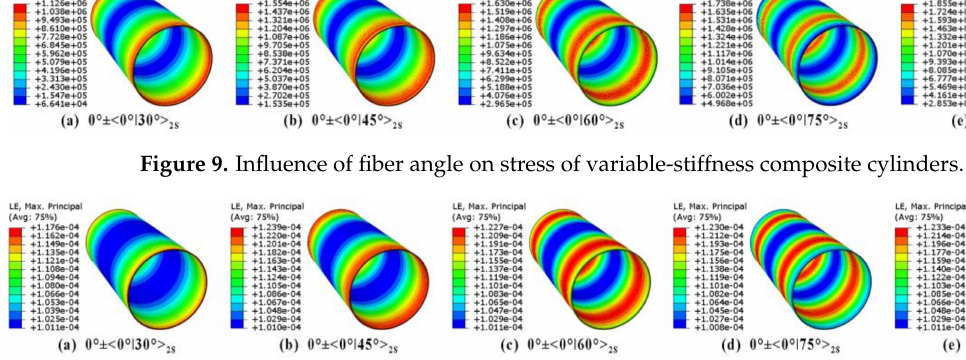
Figure 10. Influence of fiber angle on deformation of variable-stiffness composite